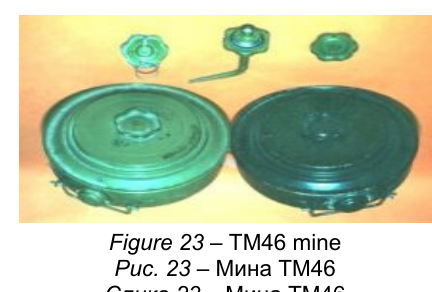
Figure 23 – TM46 mine Рис . 23 – Мина TM46 Слика 23 – Мина TM46